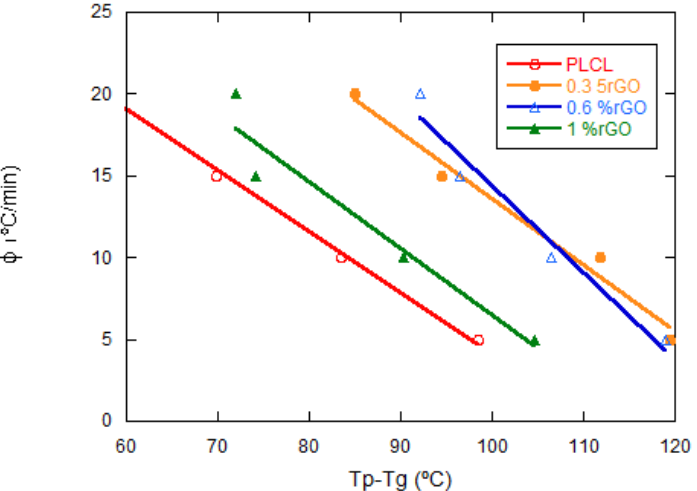
Figure 9. Effect of rGO content on the PLCL crystallization rate for the four compositions studied. Crystallization rate coefficient.